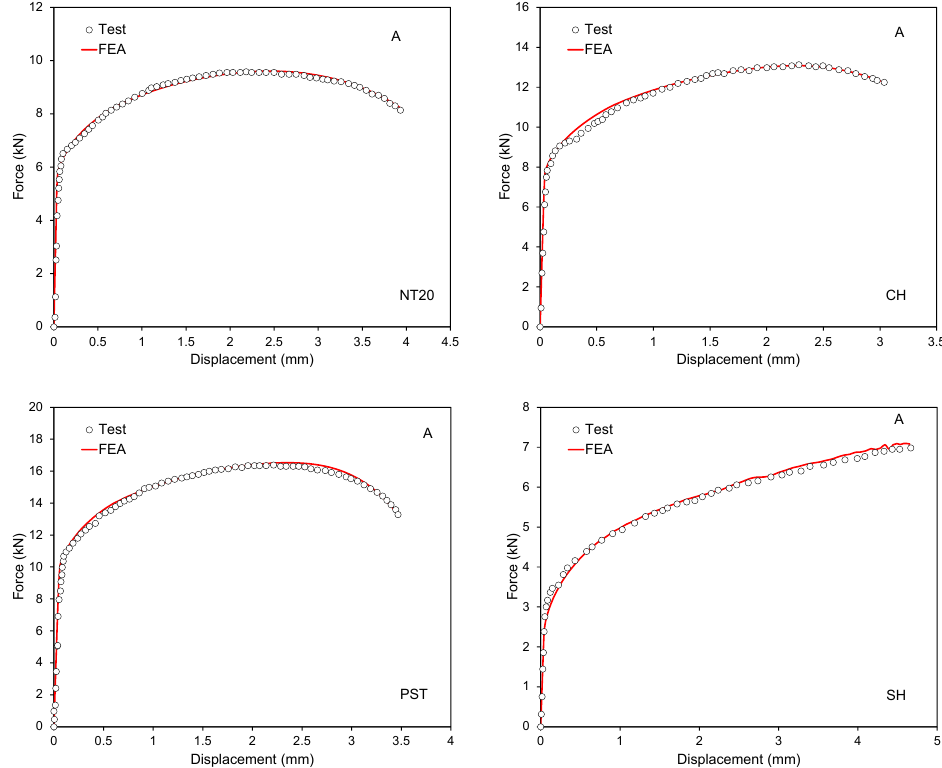
Figure 12. Comparison of force-displacement curves for the A grade steel specimens.